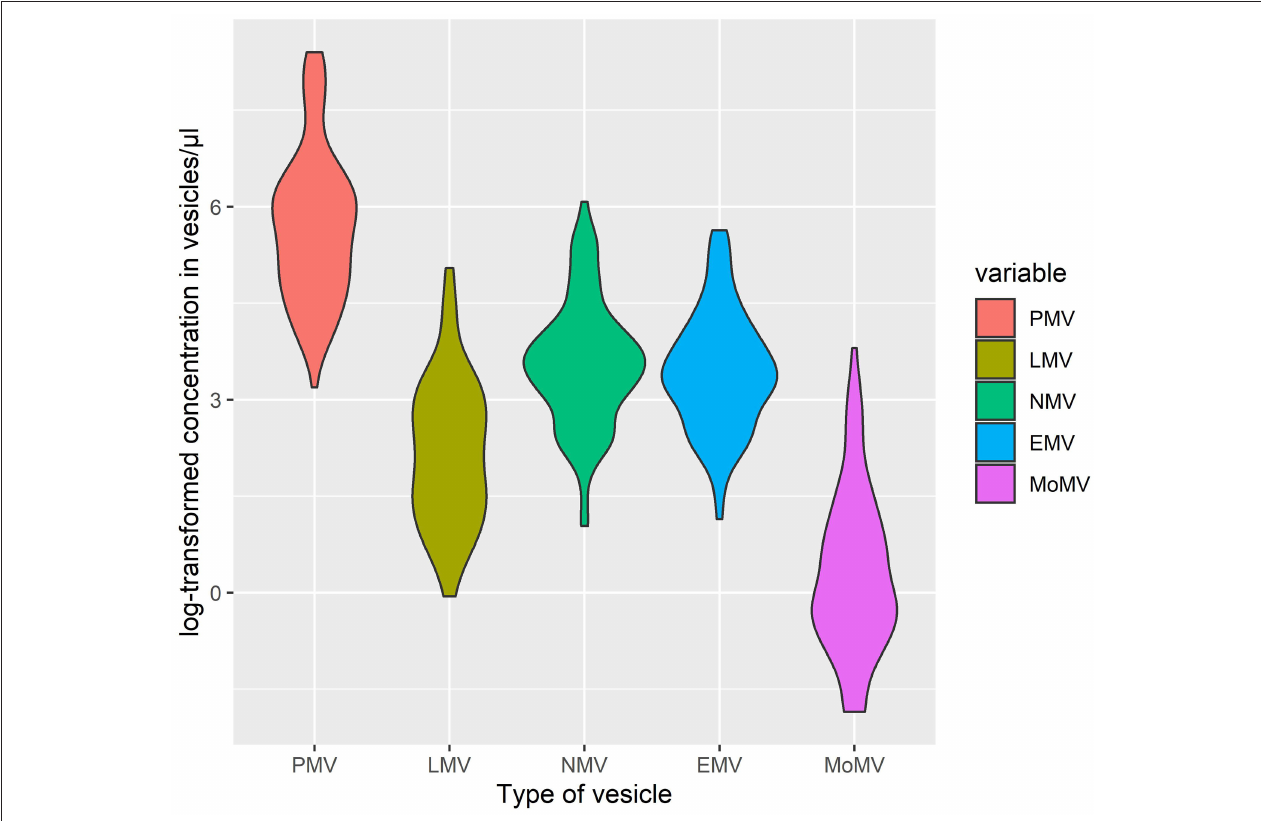
FIGURE 2 | Violin-plot of log-transformed concentrations of extracellular vesicles subpopulations at baseline. PV, platelet-derived vesicles; LV, leukocyte-derived vesicles; NV, neuronal-derived vesicles; EnV, endothelial-derived vesicles; MoV, monocytal-derived vesicles.